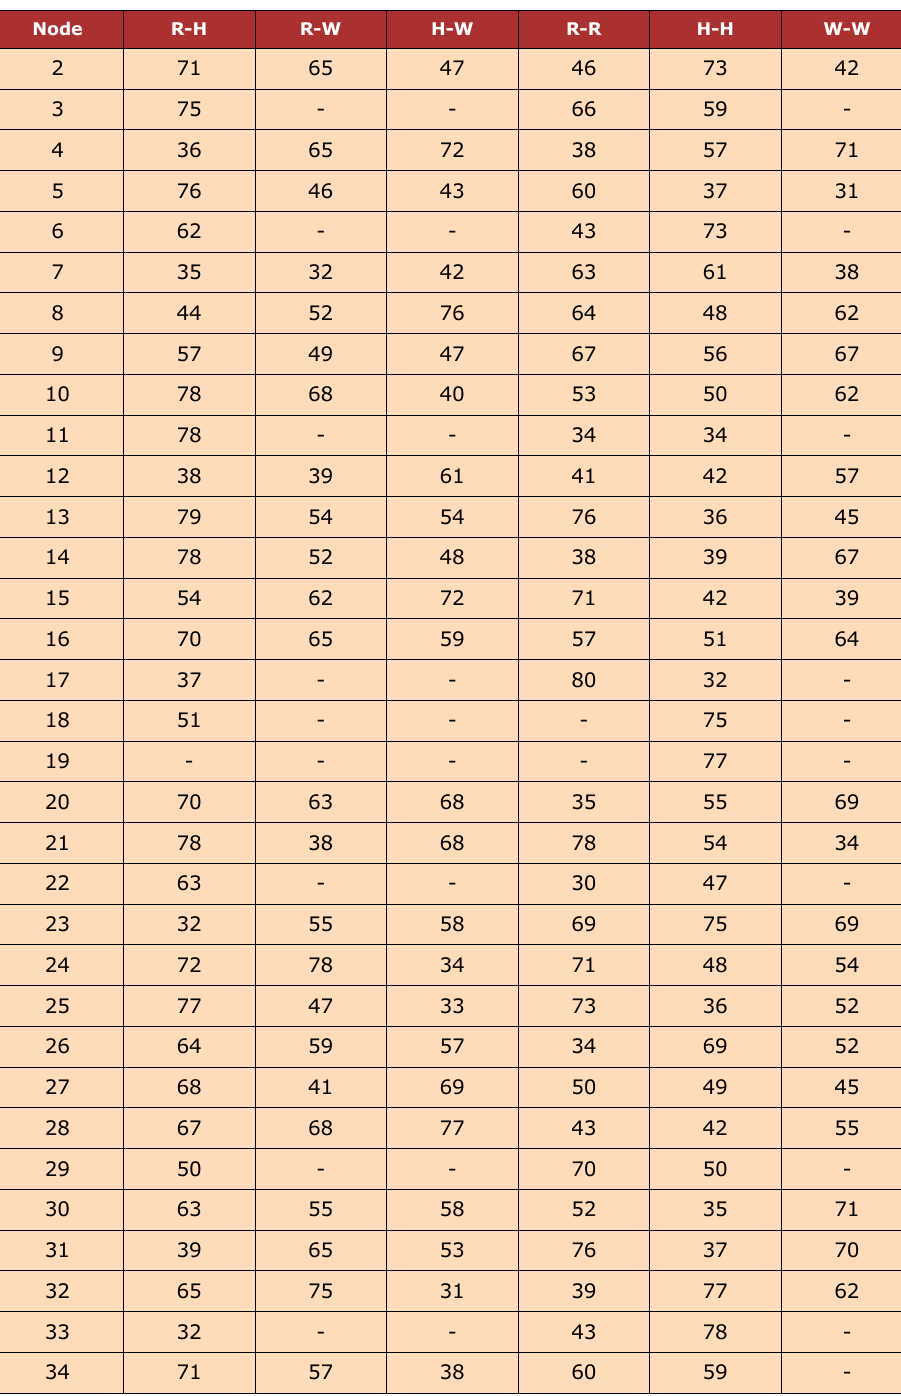
Table 5. Transshipping capacities of the transshipping